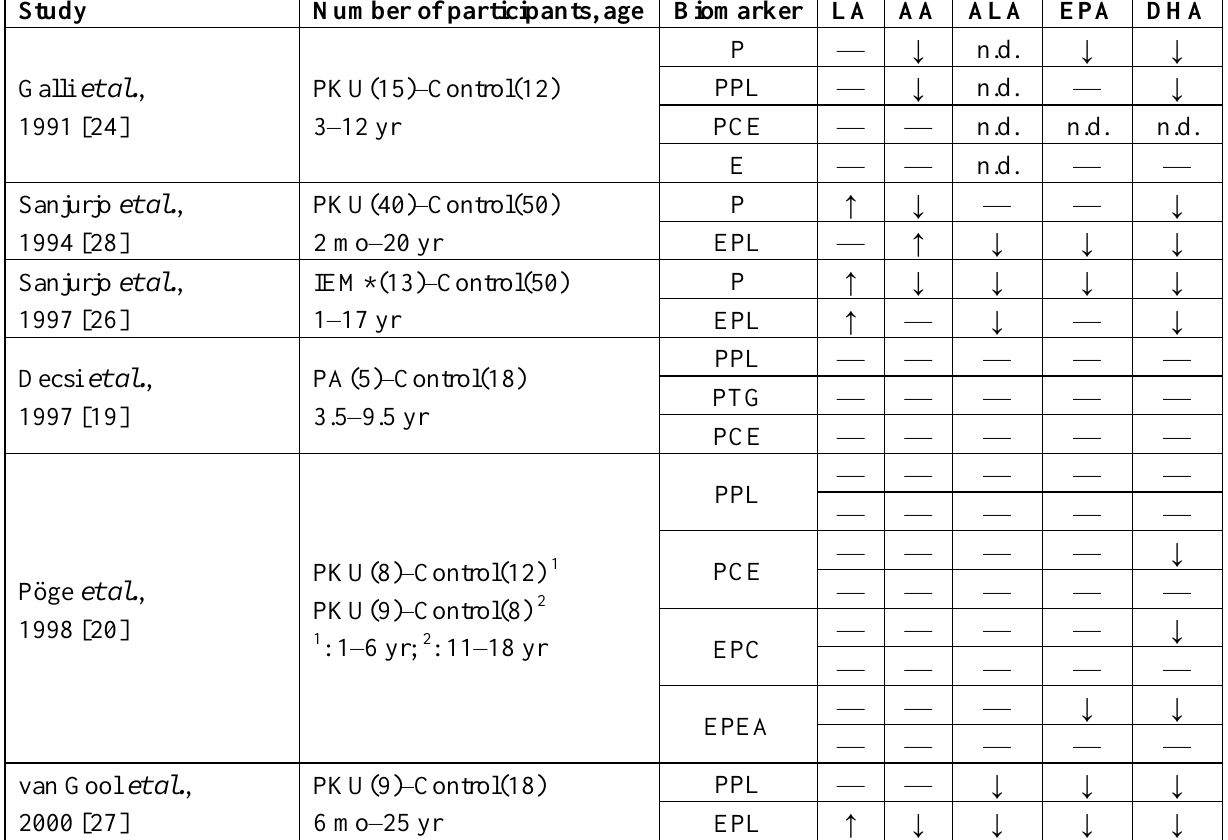
Table 1. Observational studies on the availability of long-chain polyunsaturated fatty acids in inborn errors of metabolism. Number of participants in the IEM* group: methylmalonic acidemia (5), ornithine transcarbamylase deficiency (7), citrullinemia (1); number of participants in the IEM** group: ornithine transcarbamylase deficency (7), argininosuccinic aciduria (4), methylmalonic acidemia (6), PA (3), MSUD (1), tyrosinemia type I